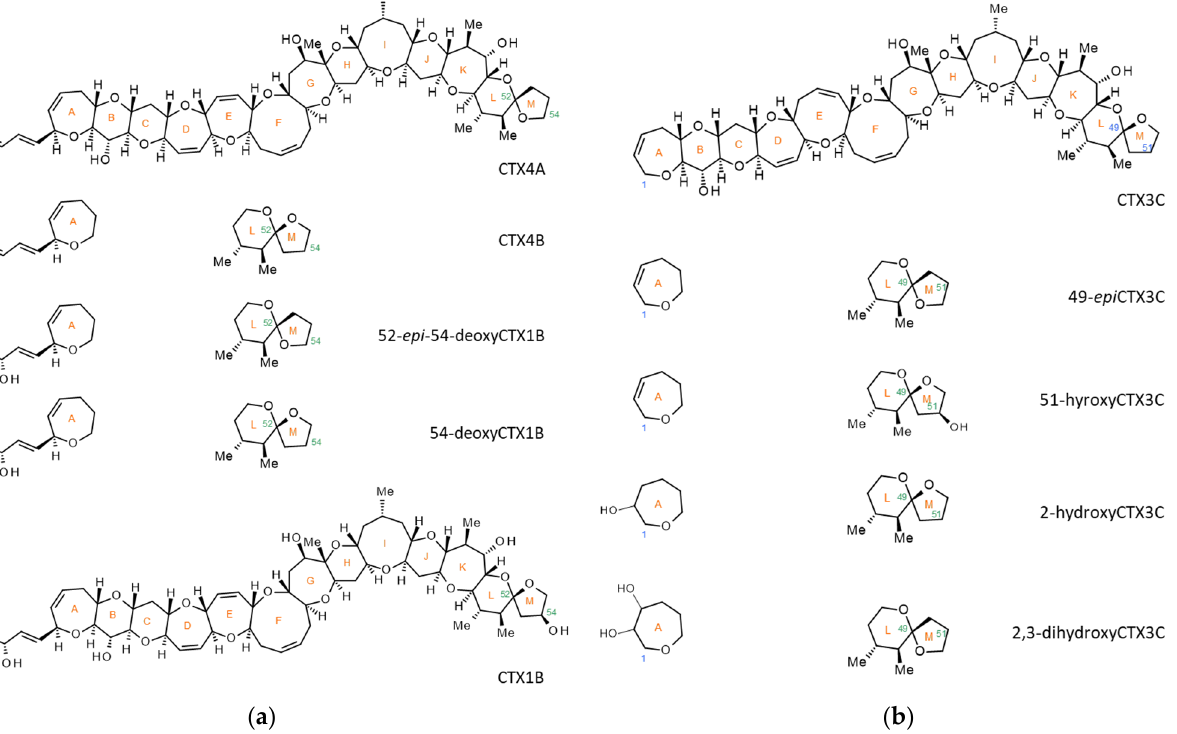
Figure 1. The chemical structures of the representative ciguatoxins (CTXs) reported from the Pacific. CTX1B group toxins derived from CTX4A and 4B ( a ) and CTX3C group toxins derived from 49- epi CTX3C and CTX3C ( b ). 49- epi CTX3C and CTX3C ( b